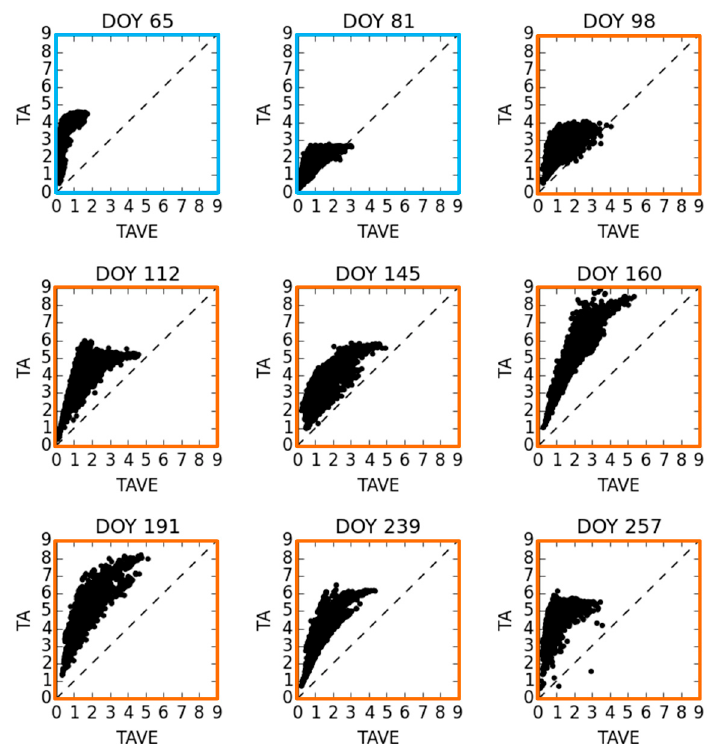
Figure 7. Comparison of the AET estimates derived by TAVE and TA over nine selected days of year (DOY). AET is in mm/day. DOY 65 and 81 are representative days of the wet season from October to March (blue frame). DOY 98, 112, 145, 160, 191, 239, and 257 are representative days of the dry season from April to September (orange frame). The dashed line is the 1:1 line of perfect agreement between TA and TAVE.